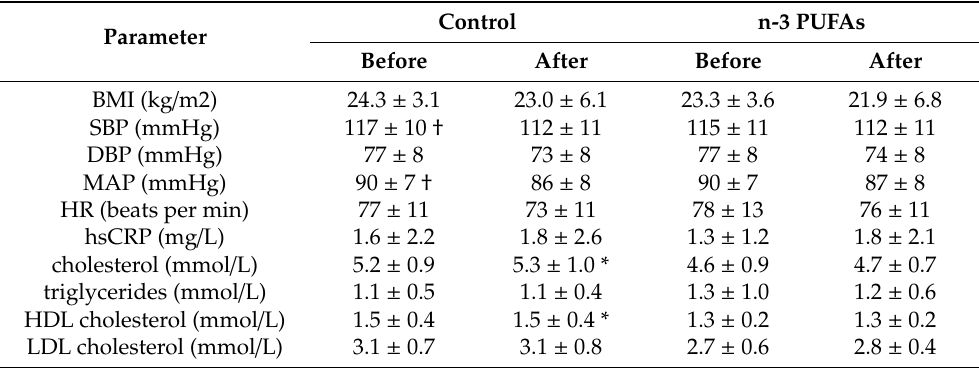
Table 3. The e ff ect of regular (Control group) and n-3 PUFAs enriched hen eggs (n-3 PUFAs group) consumption on anthropometric, hemodynamic, and biochemical